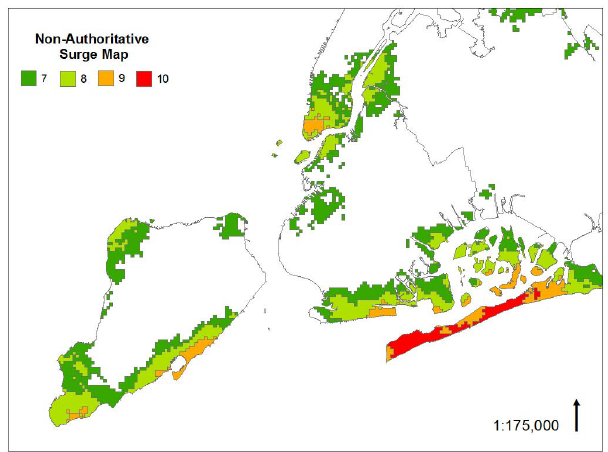
Fig. 8. Designated areas ranging from medium to severely damaged (medium=7, 8 severe=9, 10) based on non-authoritative